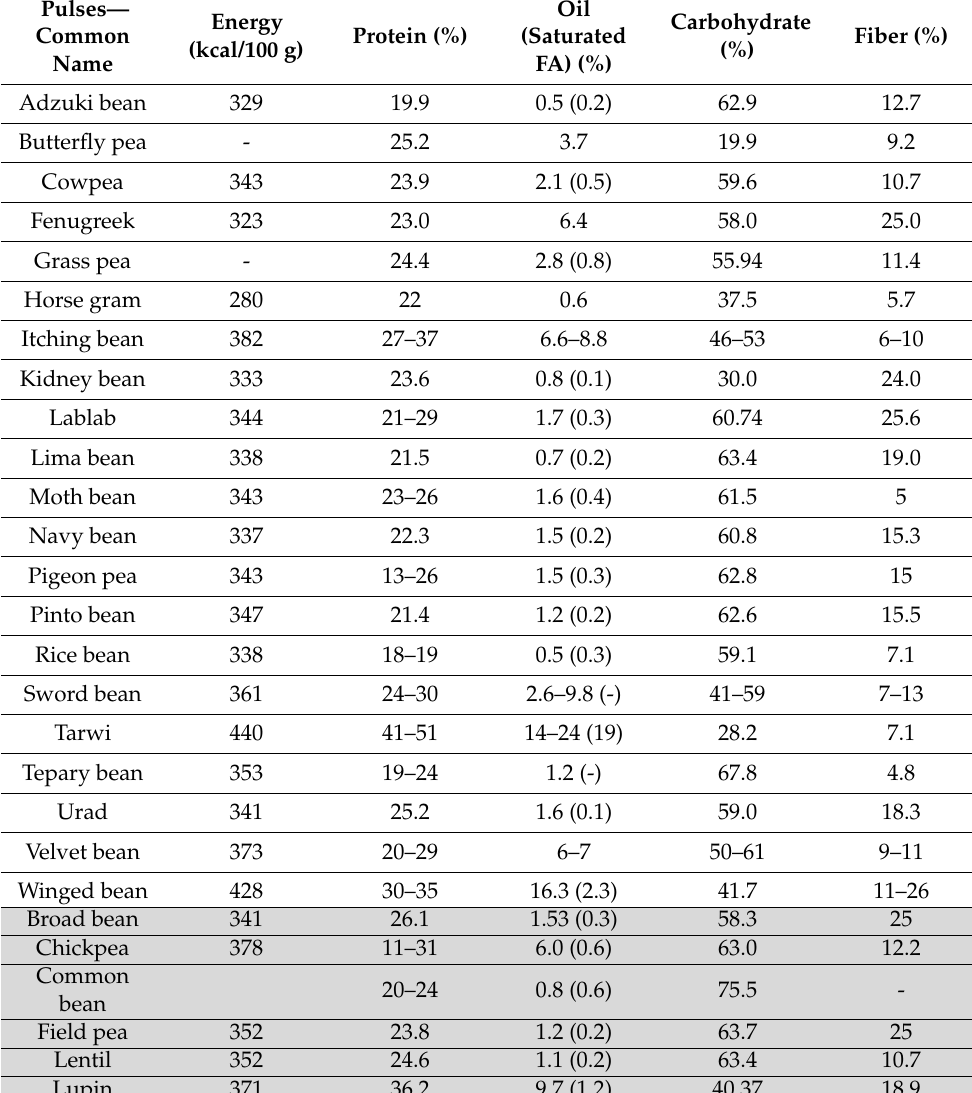
Table 4. Nutritional profile of pulses, extracted from Appendix